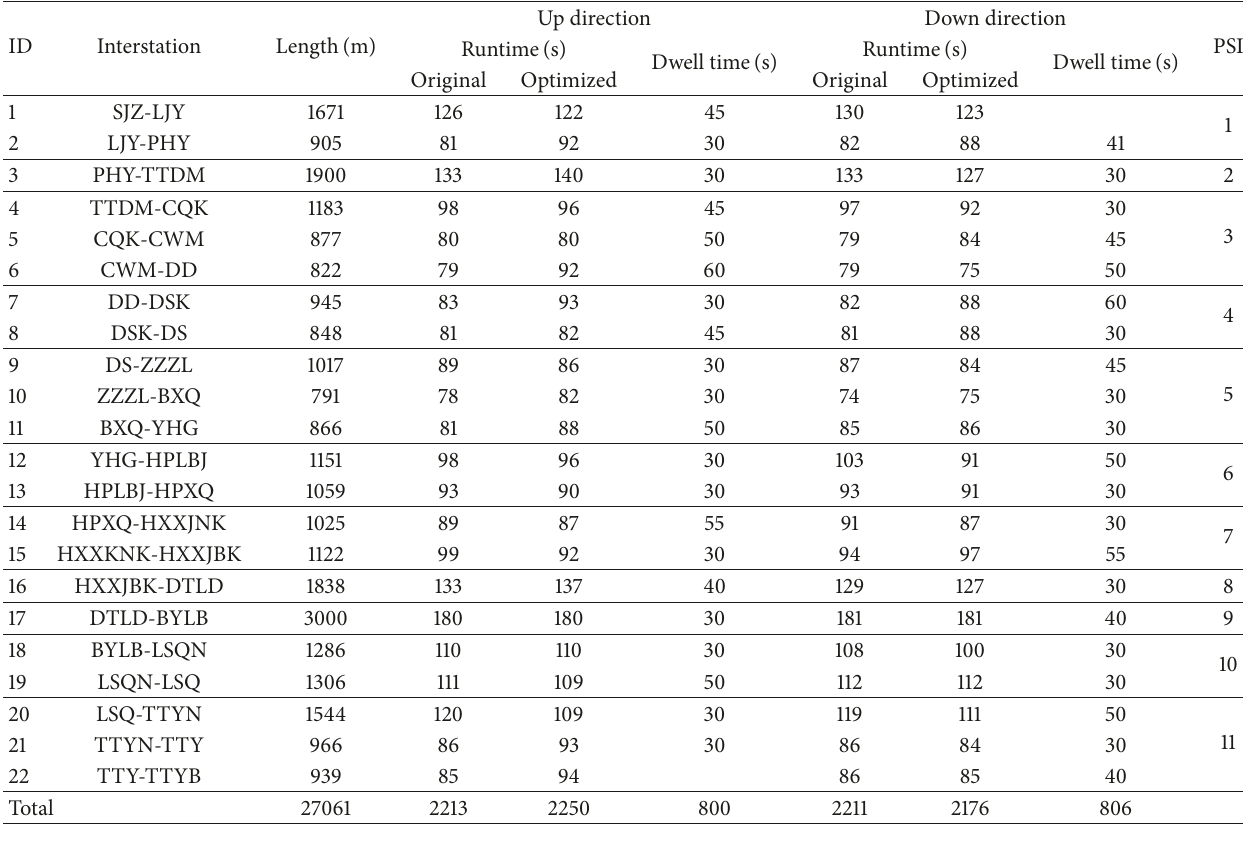
Table 4: The original timetable and the optimized timetable.